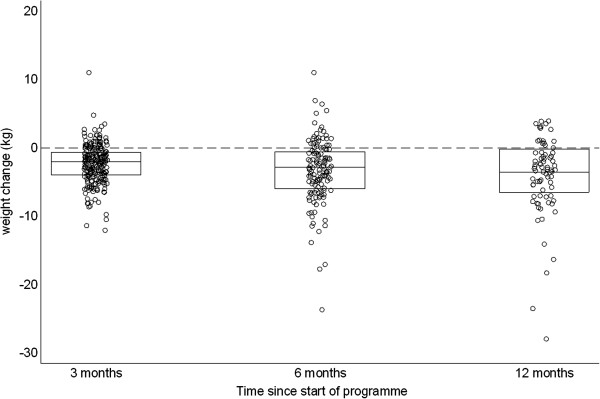
Dot plot comparing weight change at 3, 6, and 12 months since enrollment. Boxes indicate 25th, 50th and 75th percentiles.